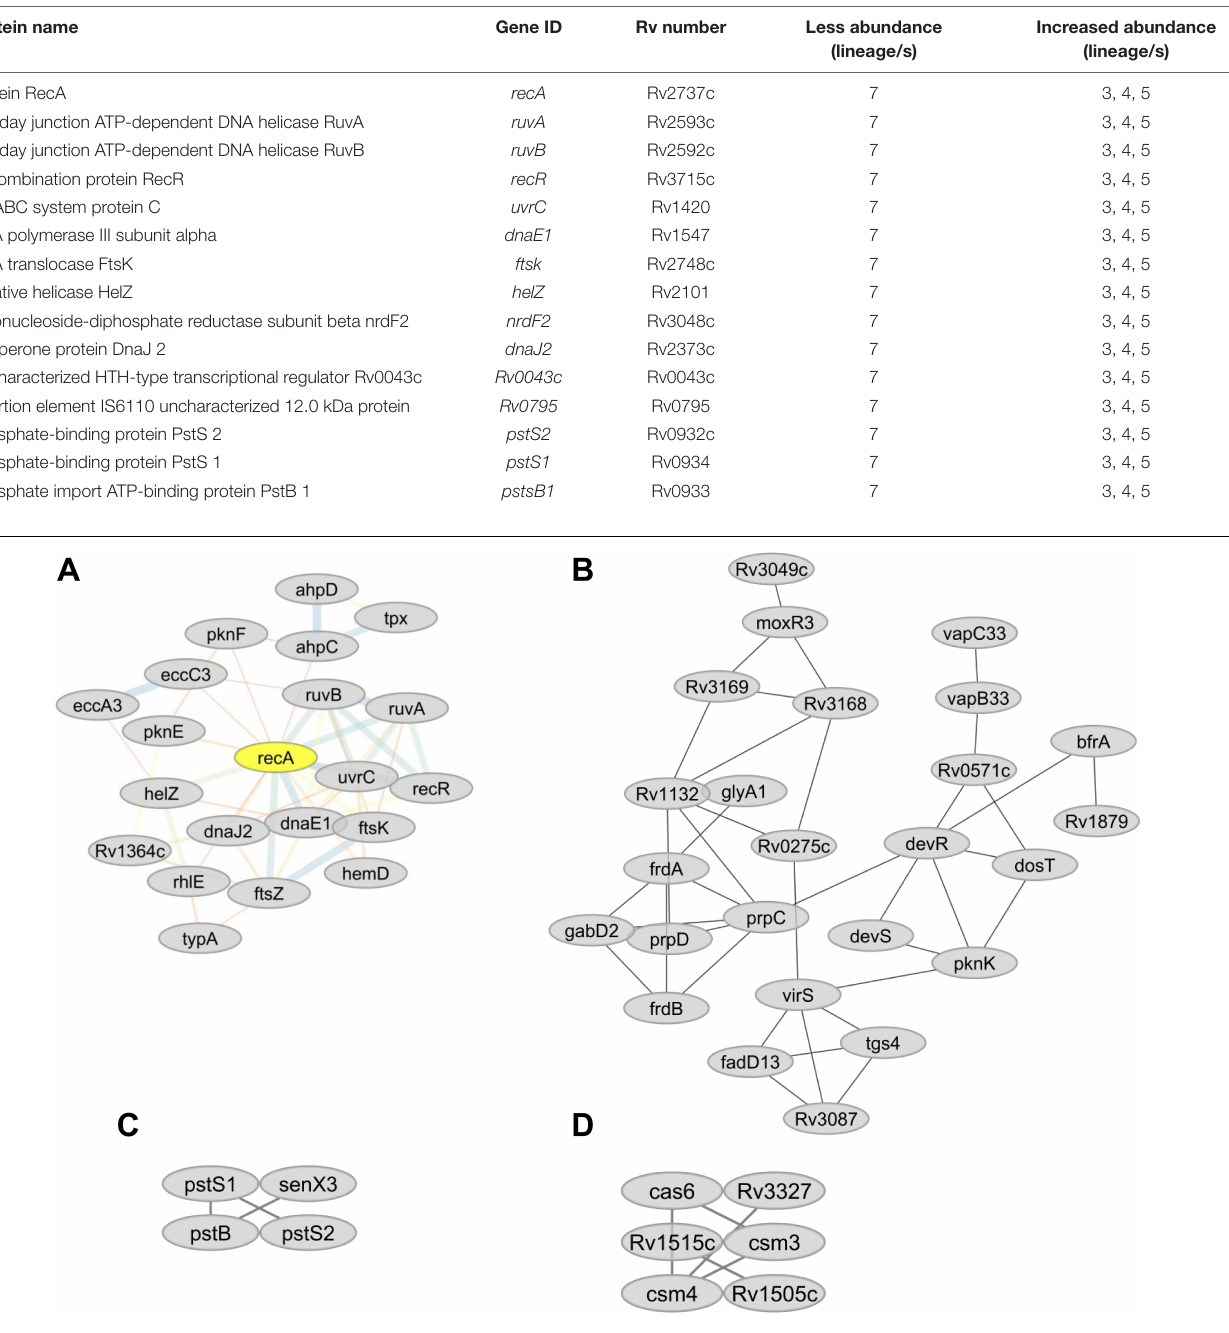
TABLE 3 | Differentially abundant proteins involved in the DNA repair and Pst systems in MTBC lineages.